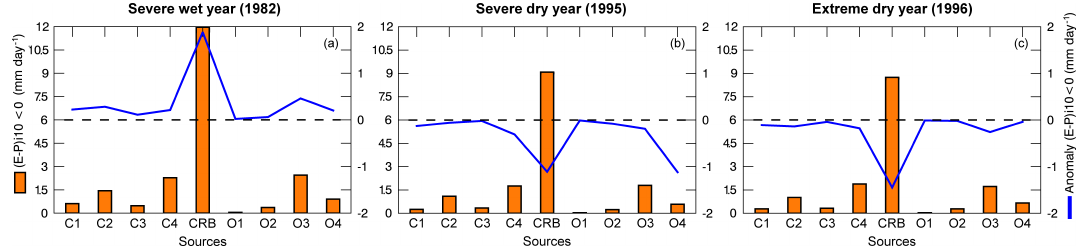
Figure 13. Mean annual moisture contribution from the sources to the CRB (orange bars) in 1982 (severe wet conditions, (a) 1995 (severe dry conditions, (b) and 1996 (extreme dry conditions, (c) alongside the corresponding anomaly (blue